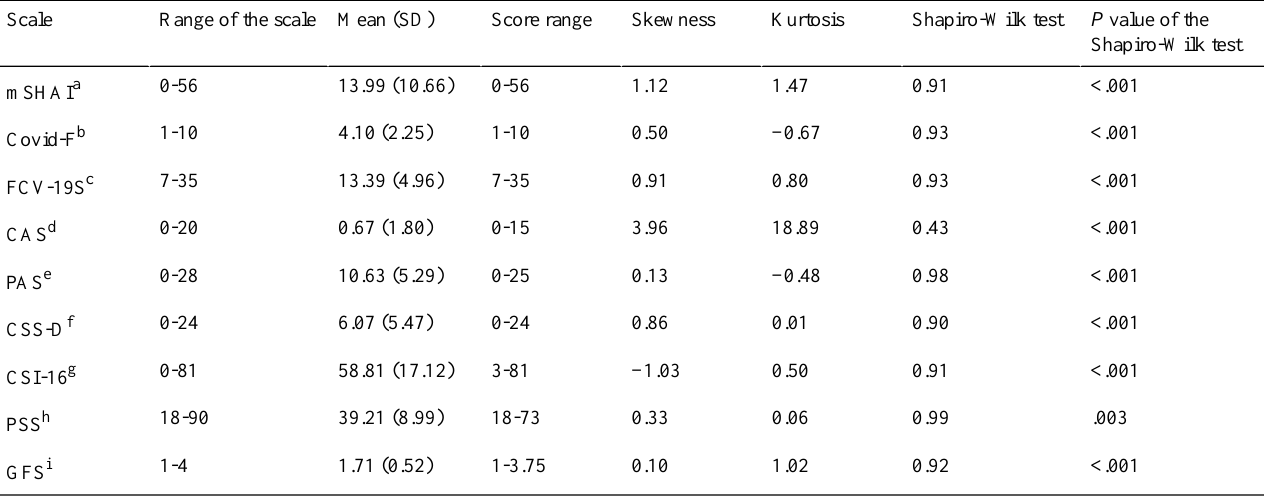
Table 2. Descriptive statistics of the scales (N=515 for all scales, except CSI-16, for which n=486).